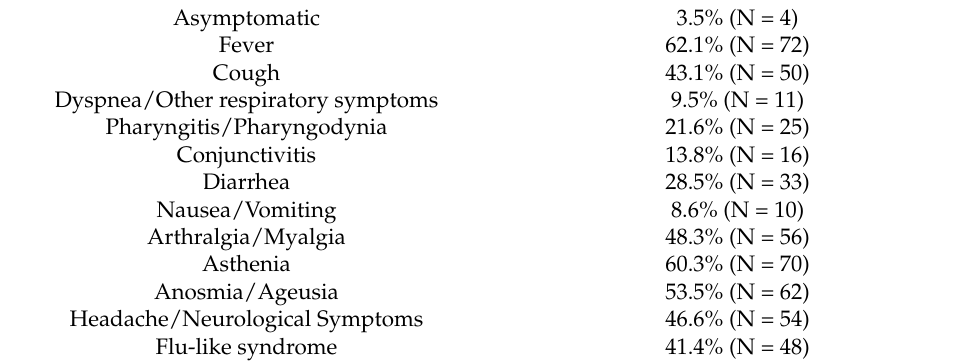
Table 3. Symptoms of positive subjects (rt-PCR) (N =